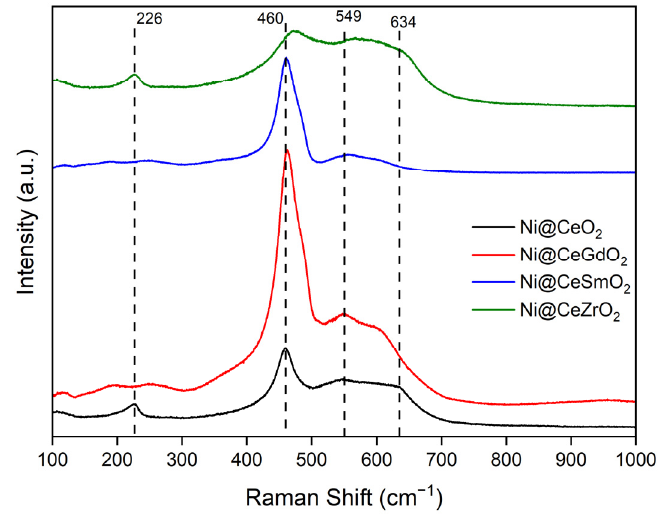
Figure 4. Raman spectra for the calcined samples.